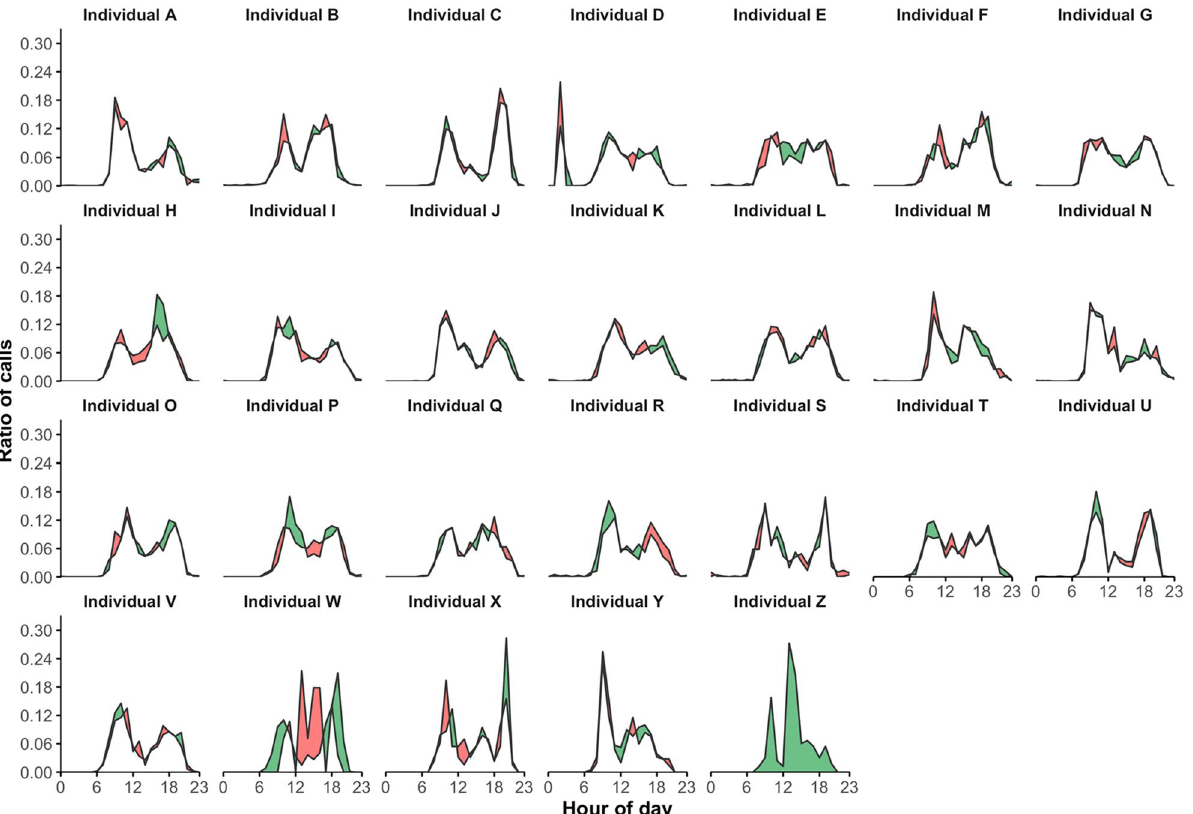
Figure 4. Comparison of two daily rhythms of total telephone call activity. Daily rhythms of total telephone call activity are calculated for the two successive time periods of 6 months each, T 1 and T 2 . Their differences are illustrated by coloring the area between the two corresponding curves: (1) in green when the ratio of calls corresponding to T 1 is higher than T 2 , and (2) in red for the